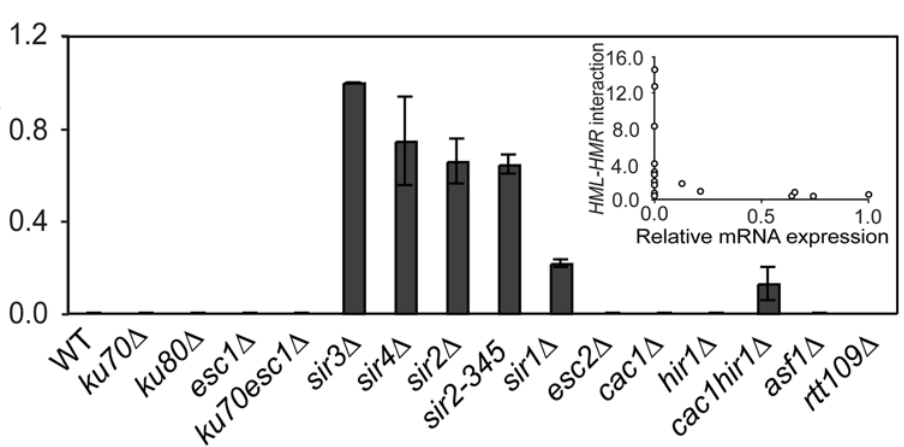
Figure 8. Silencing and HM interactions are distinct processes. RT-PCR analysis of a 1 transcription in wild-type and mutant MAT a strains analyzed by 3C. Error bar represents standard error of the mean from two independent experiments. Expression of ADH1 was used as an internal control and data was normalized to level of expression in sir3 D mutants (set at 1). Inset: Crosslinking frequency of HML-HMR interaction is plotted versus the relative mRNA expression of a 1 for all mutants analyzed to indicate that no clear correlation between silencing and HM interactions is detected.